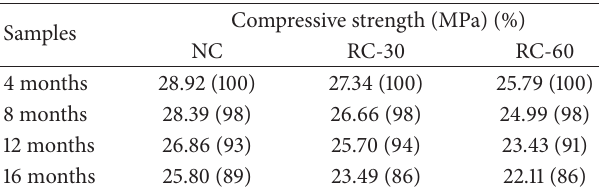
Table 4: Decreasing of compressive strength with corroding